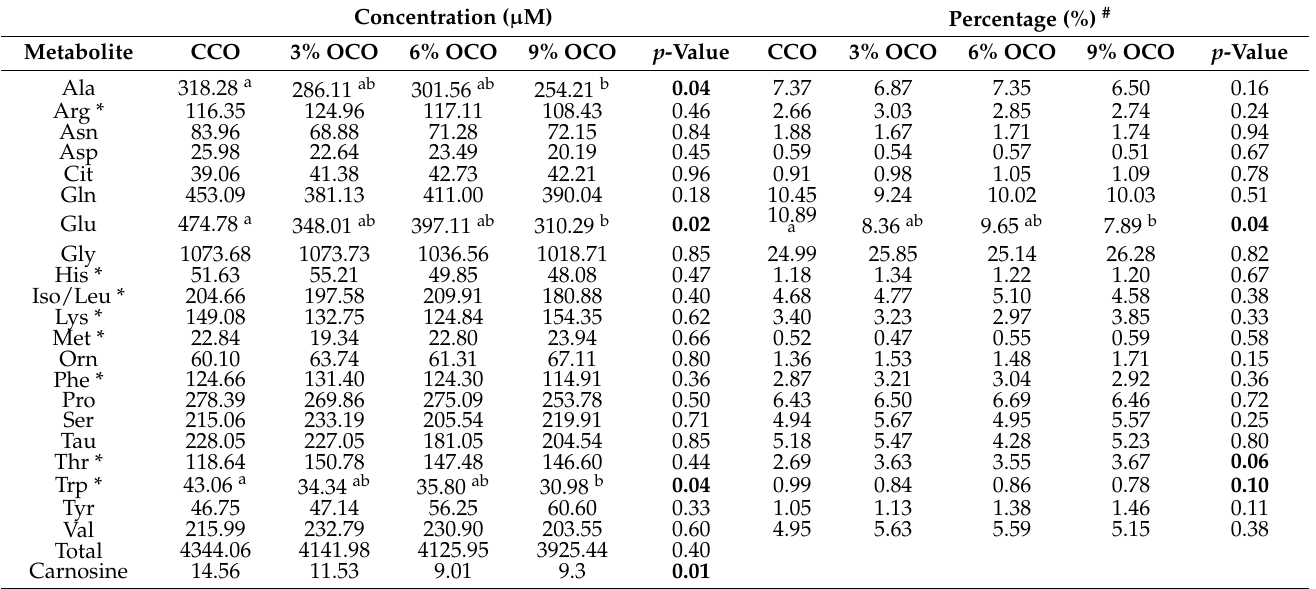
Table 1. Effects of oxidized corn oil (OCO) on serum free amino acids and carnosine. The statistical analysis was conducted by one-way ANOVA among control corn oil (CCO) and OCO treatments followed by Tukey’s post hoc test, in which the CCO was set as the control and compared with 3%, 6%, and 9% OCO treatment groups, respectively.